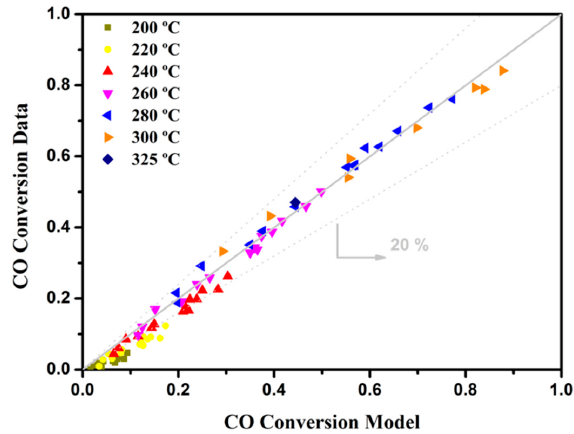
Figure 2. Plot of the calculated vs. the observed CO conversion using the proposed kinetic model for the WGS reaction, Equation (15), on powdered PtCeAl + ZrEuMo (1:5) catalyst. The estimated kinetic parameters are in good agreement with those found for similar Pt-based catalysts. For instance, the activation energy as well as the reaction orders are comparable to those reported by Phatak et al. [4], where the activation energies vary between 68 and 84 kJ/mol and the reaction orders are close to zero for CO and CO 2 , from − 0.38 to − 0.49 for H 2 , and high values, between 0.77 and 1.1 are reported for H 2 O. Only when the Pt is supported on CeO 2 a reaction order for H 2 O as low as 0.44 is reported. This is probably due to the promoter effect of ceria on water activation, which is also in concordance with the idea proposed in this work. Similar results for E a (~70 kJ/mol) and reaction orders ( − 0.36 and 0.63 for H 2 and H 2 O, respectively) are obtained by Grabow et al. [2] using both theoretical DFT analysis and experimental data for a Pt/Al 2 O 3 catalyst. Furthermore, Germani et al. determined the kinetic parameters using both power law based and LH based reaction rate expressions for the WGS reaction on microstructured Pt/CeO 2 /Al 2 O 3 catalysts [1,42]. These authors fit their data considering reaction orders equal to 0.49 and − 0.45 for H 2 O and H 2 , respectively, and activation energies of 86 kJ/mol and 76.8 kJ/mol for the Pt-based catalysts depending on the catalyst preparation method. On considering the LH-based rate law expression, an activation energy of 78.2 kJ/mol is calculated. Moreover, the highest adsorption constant is obtained for H 2 that they assume, as in this work, independent of temperature. Therefore, the kinetic model proposed in